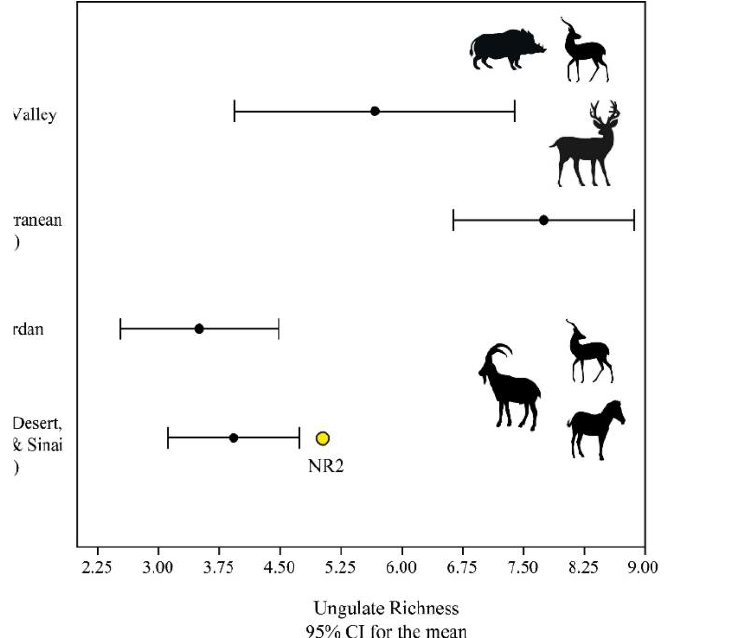
Figure 8: Ungulate richness with 95% CI bars for Upper Paleolithic assemblages from the southern Levant. Data from Rabinovich